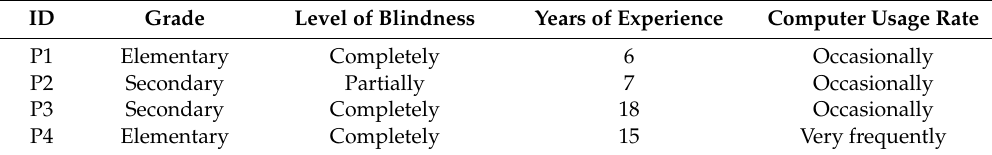
Table 3. Profiles of